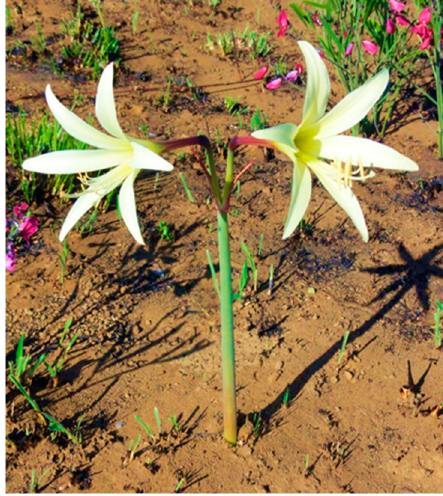
Figure 1. Hippeastrum stapfianum flowers in Brazilian savannah (Cerrado).